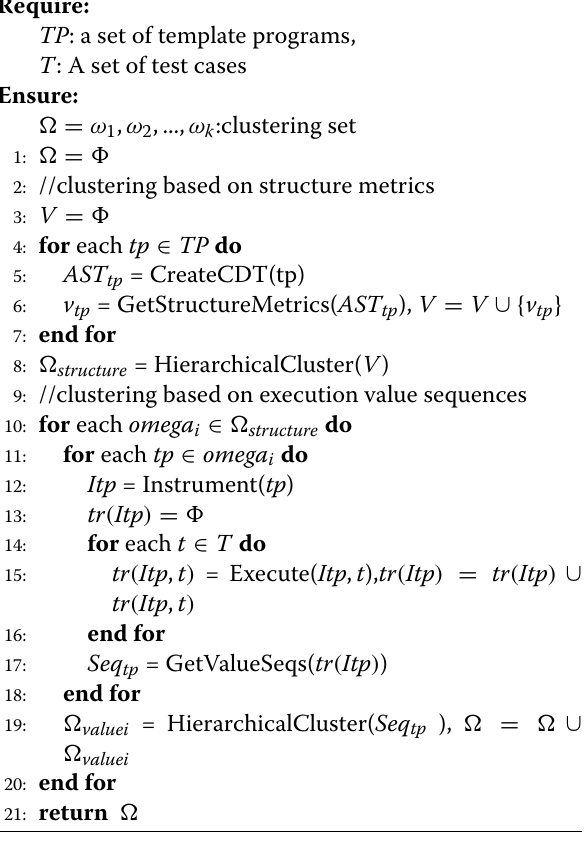
Algorithm 1 Clustering programs with code